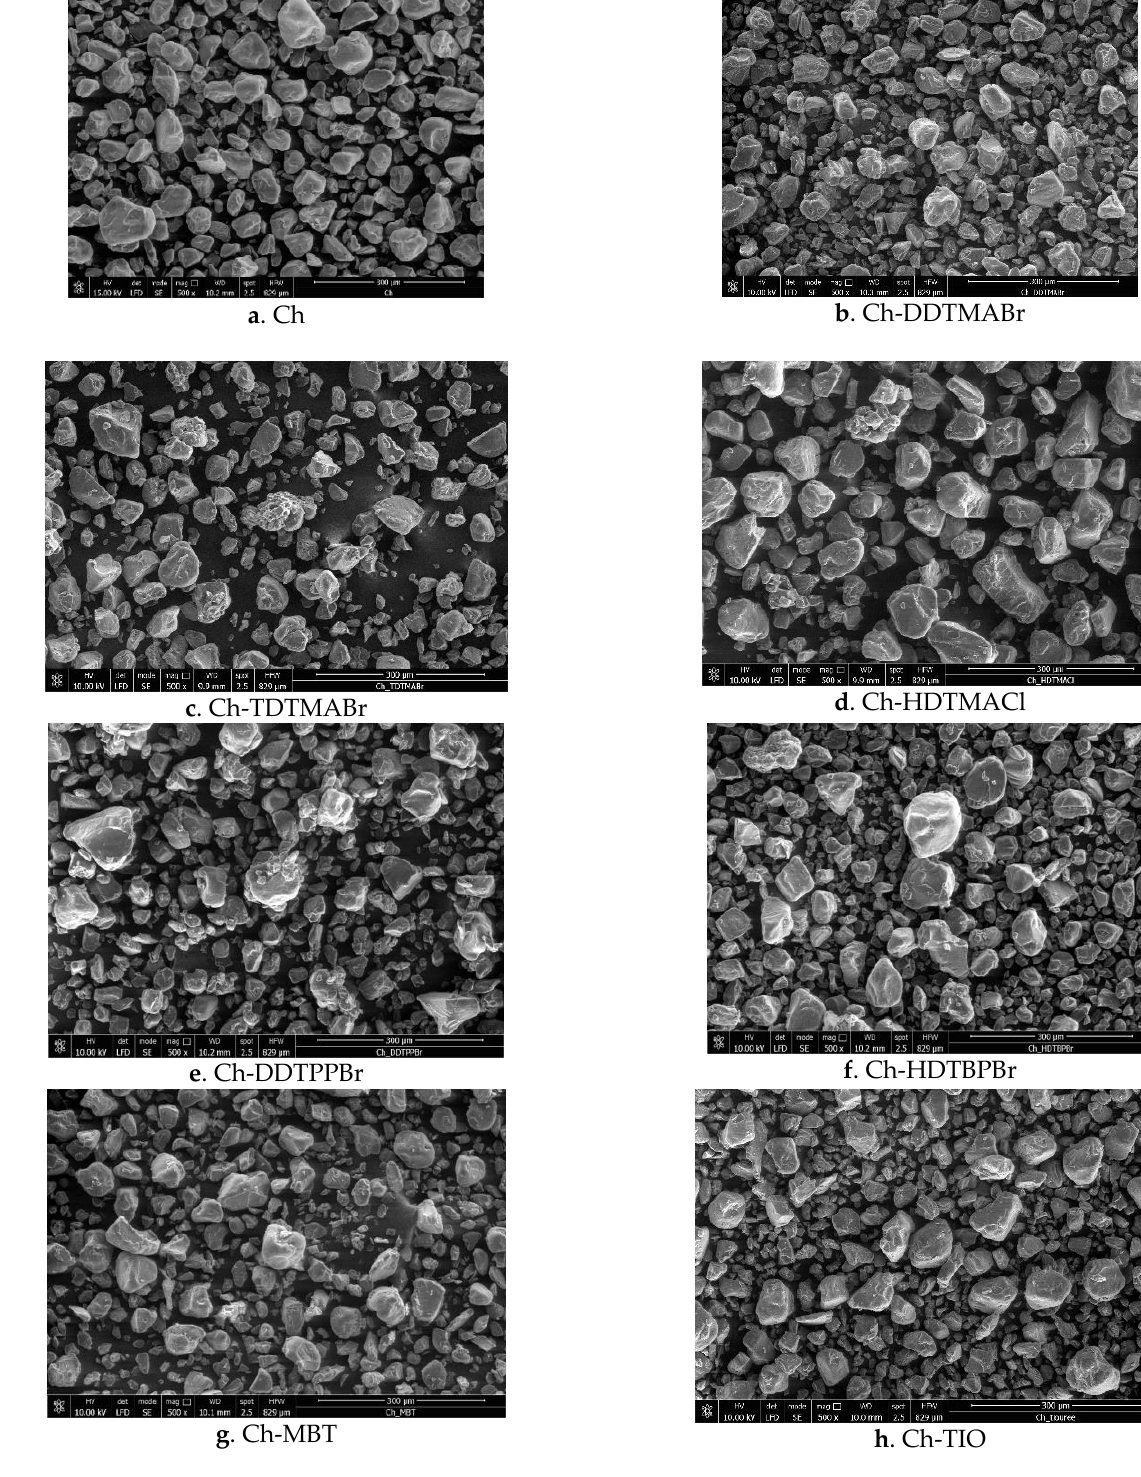
Figure 1. ( a – h ) SEM images for materials obtained by functionalizing chitosan with different